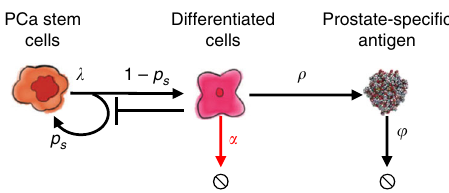
Fig. 9 Model of prostate cancer stem-like cell and non-stem (differentiated) cell dynamics. Interactions between stem-like and non- stem cells, as well as serum PSA. Stem-like cells can divide asymmetrically to produce differentiated cells. The differentiated cells inhibit the production of PCaSCs, die in response to ADT (shown by the red arrow), and produce PSA. Parameters are stem cell proliferation rate ( λ ), stem cell self-renewal p s , ADT cytotoxicity α , PSA production rate ρ , and PSA